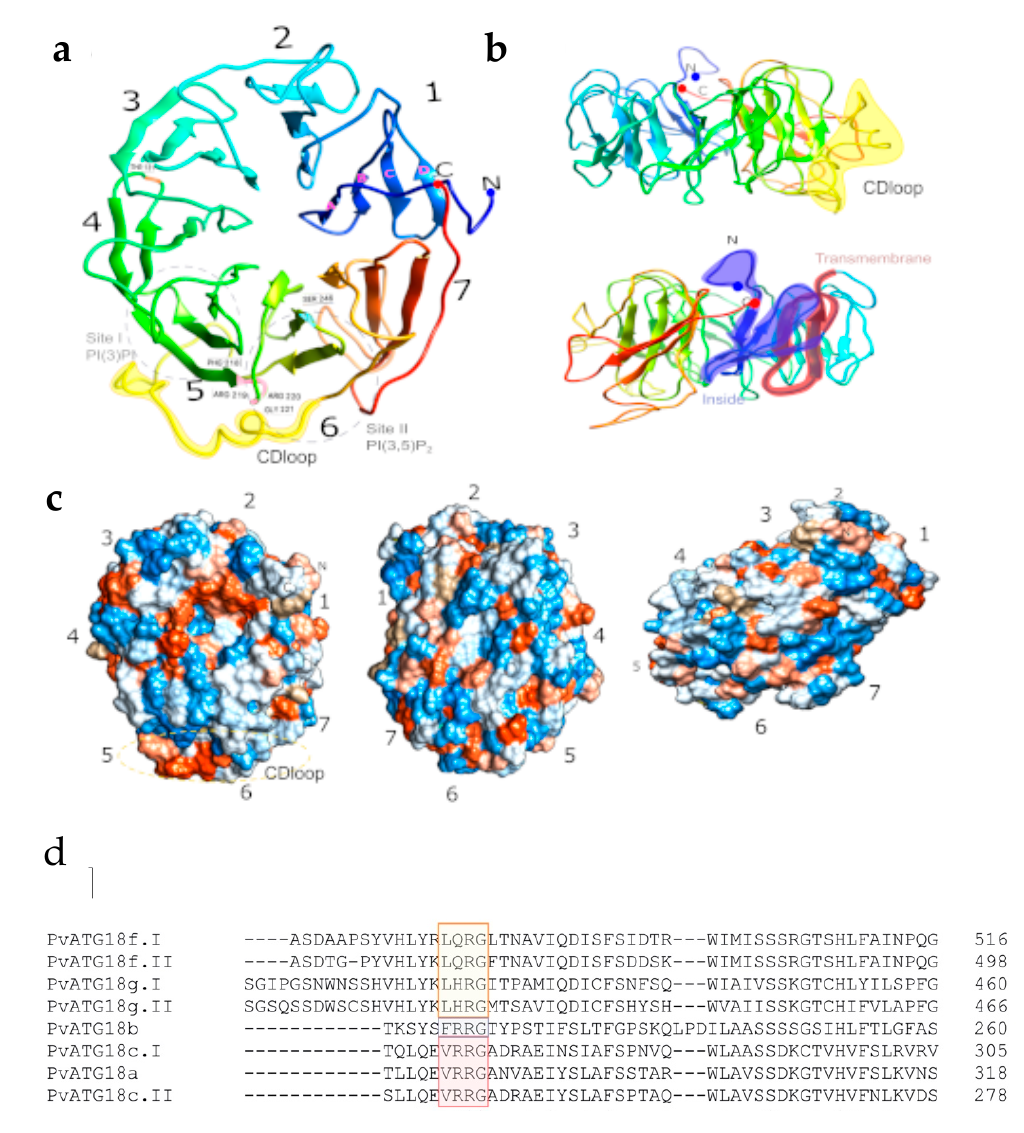
Figure 10. Three-dimensional structural model of PvATG18b determined by molecular dynamics simulation and alignment of ATG18 protein sequences of P. vulgaris . ( a ) The PvATG18b protein structure preserves seven blades of four β -strands. ( a – d ) In the colored rainbow, the N-terminus is shown in blue, the C-terminal is shown in red, the FRRG repeat (F218-G221) is colored pink, the conserved T131 residue is shown in orange and S246 Ser is presented in blue. The region consisting of site I PI(3)P and site II PI(3,5)P 2 are shown in the gray circle. ( b ) PvATG18b protein structure rotated 180 ◦ and showing the CD loop (S269-T288) in yellow. ( c ) PvATG18b protein structure surfaces (positive and negative charges are shown in blue and red, respectively) showing a nonspecific electrostatic charge. ( d ) The FRRG repeat position is highlighted with the following colors: Subfamily I (yellow), subfamily II (purple) and subfamily III (red).